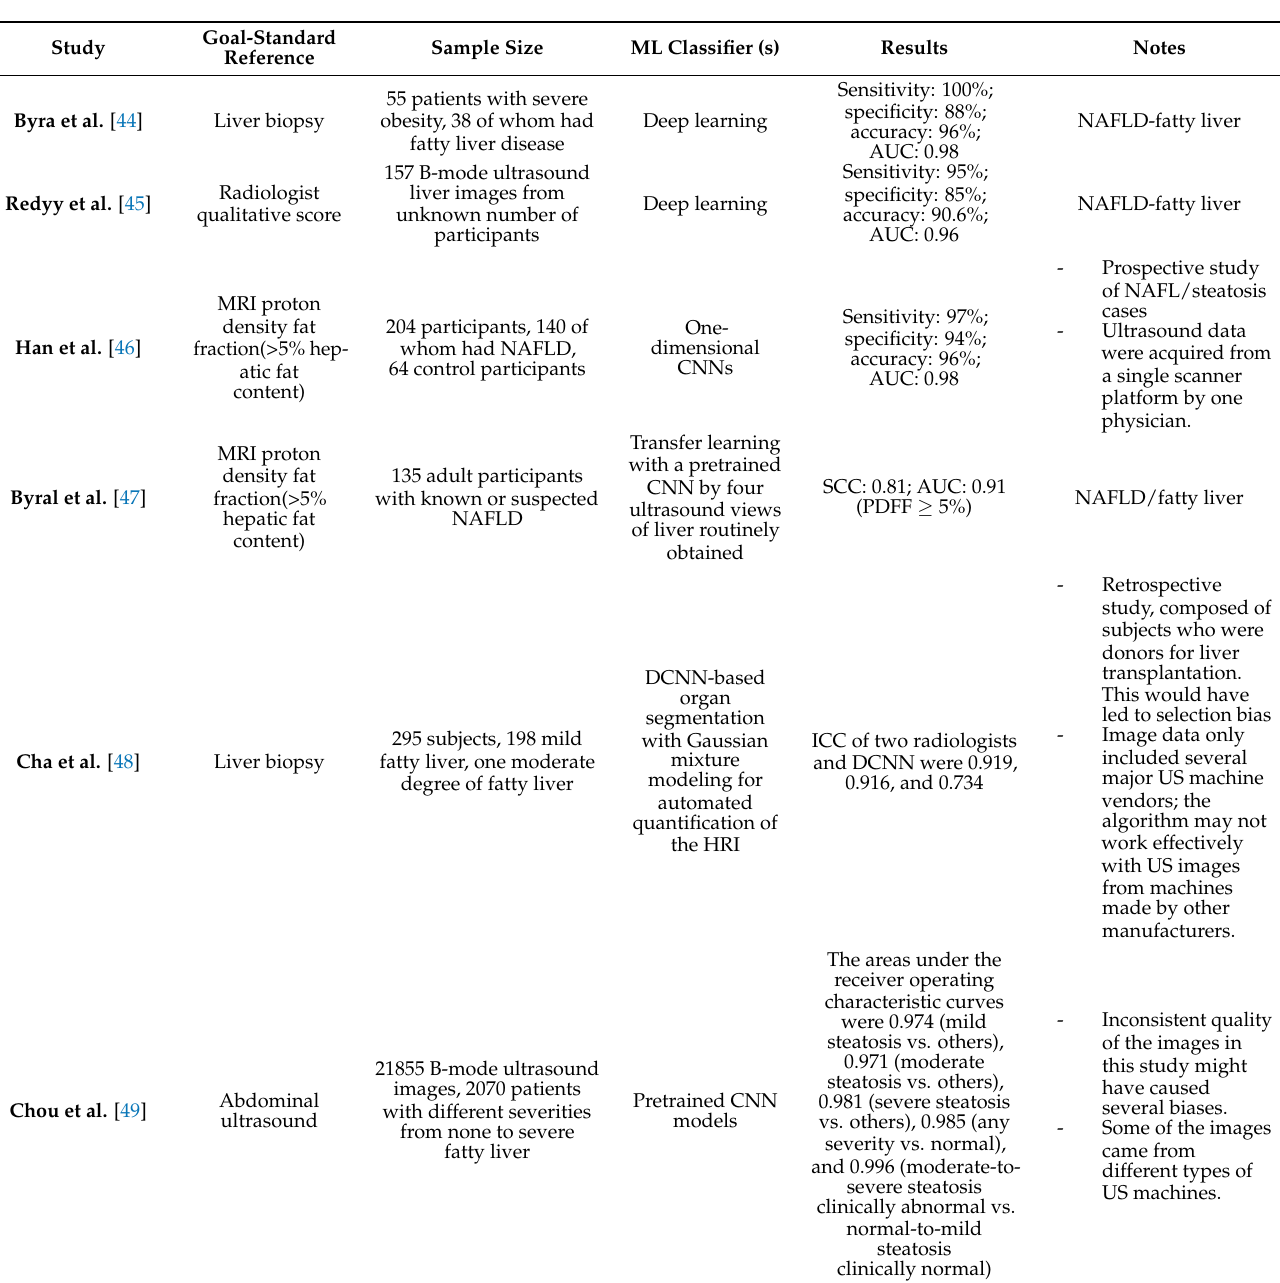
Table 4. Literature review of the use of ML for liver disease